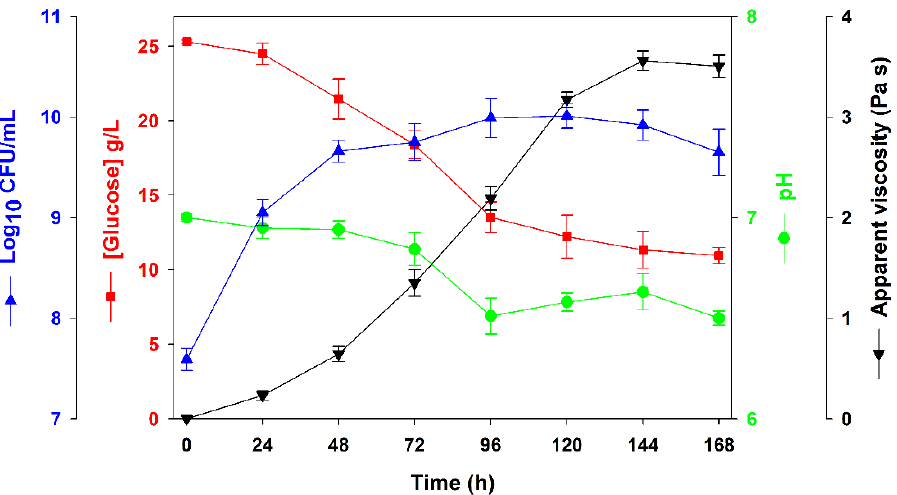
Figure 1. Time course of apparent viscosity (Pa s), colony-forming units (Log 10 CFU/mL), glucose concentration (g/L) and pH in assays performed with Rhizobium viscosum CECT908 grown in synthetic medium in flasks at 28 °C and 180 rpm. The results represent the average of triplicate experiments ± standard deviation.